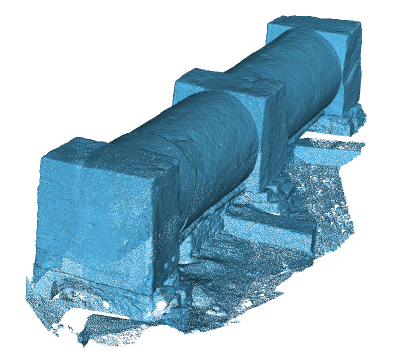
Figure 3. The result of the laser scanning